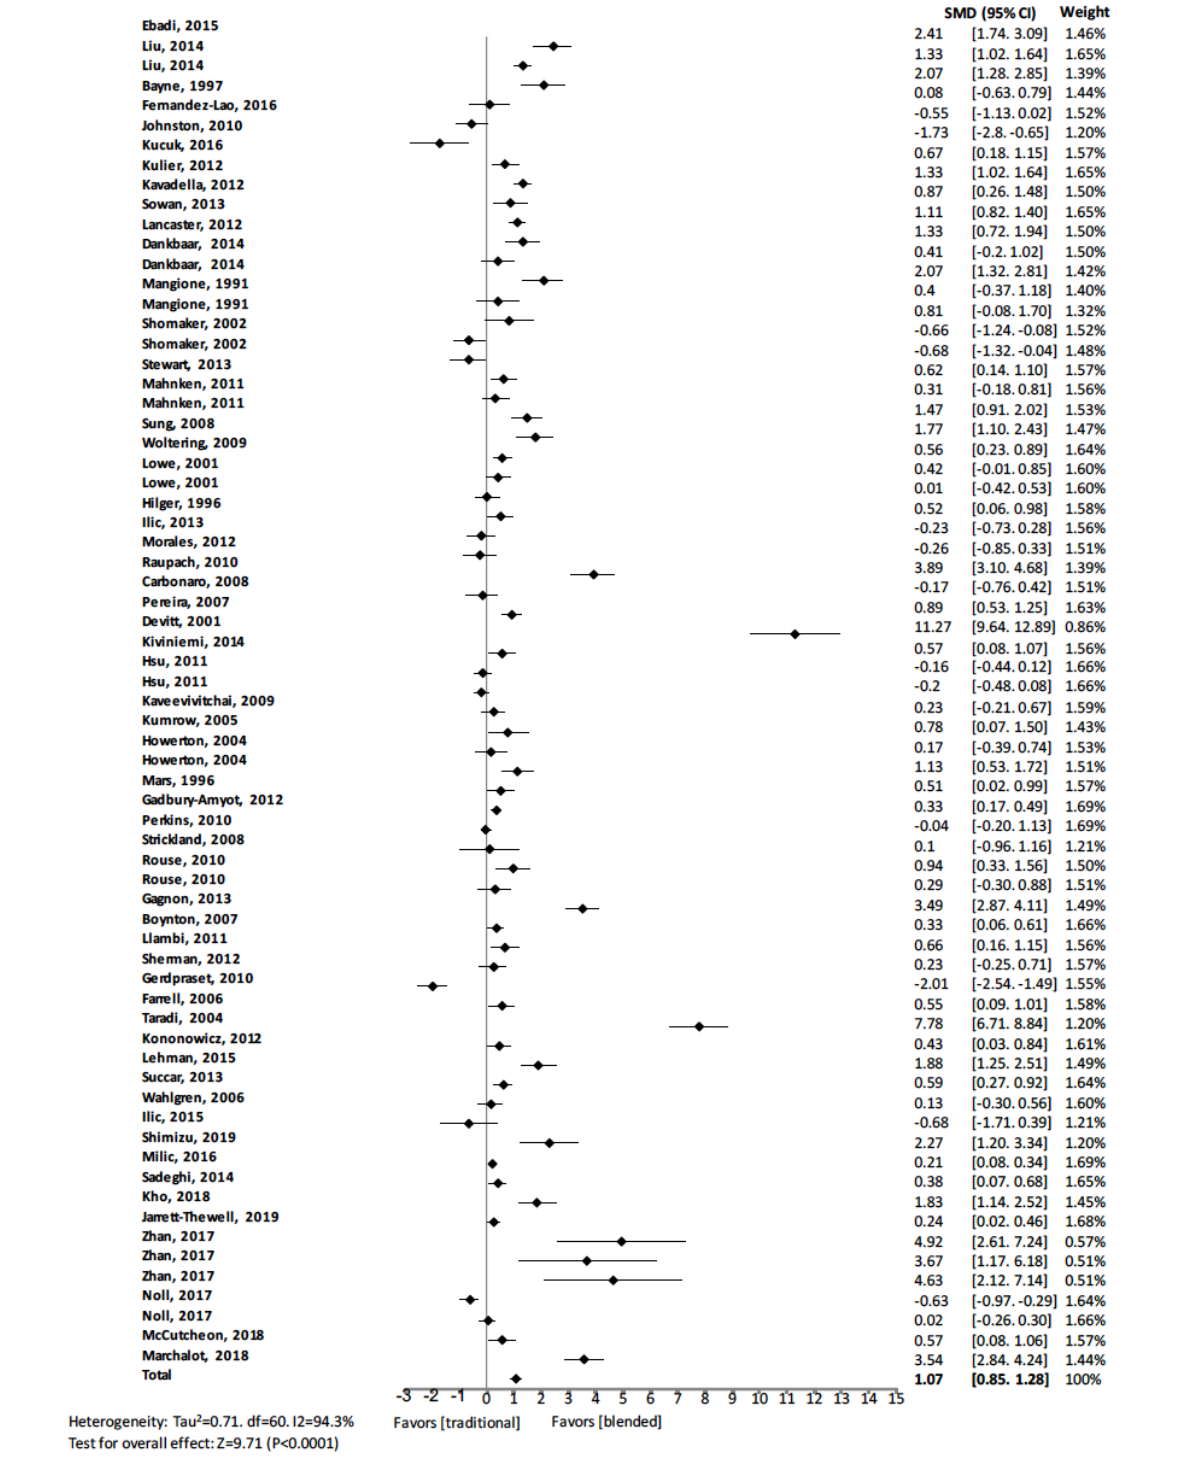
Figure 2. Forest plot of blended learning to traditional learning comparison for knowledge outcomes. df: degree of freedom; CI: confidence interval; SMD: standard mean